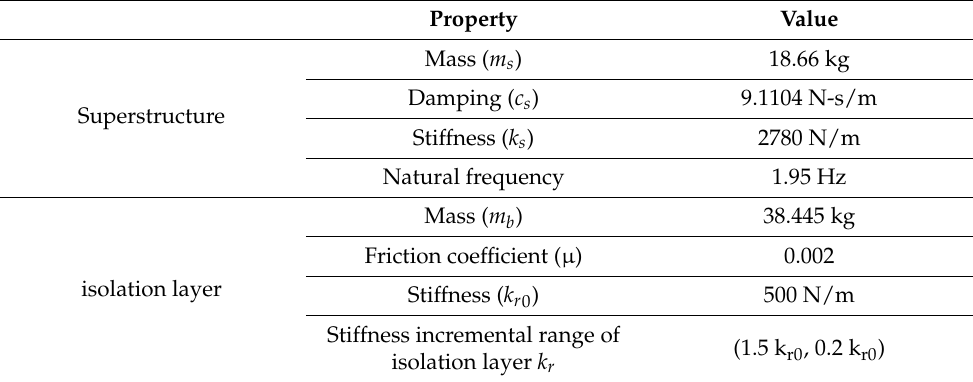
Table 5. Identified parameters of the LSCIS